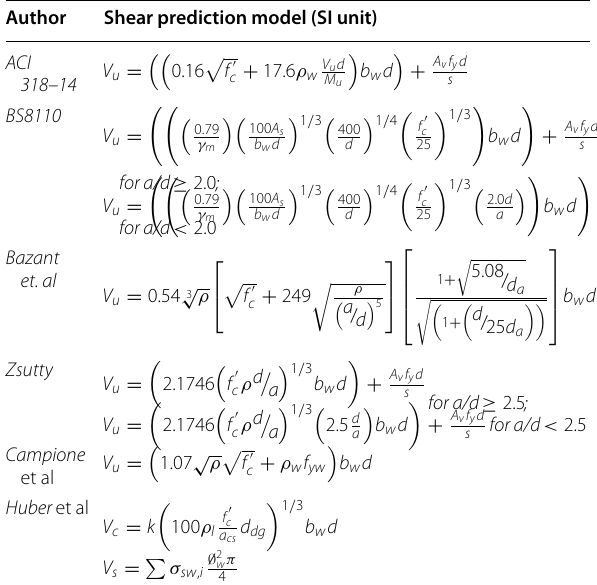
Table 6 Shear prediction models for beams with and without shear reinforcement.